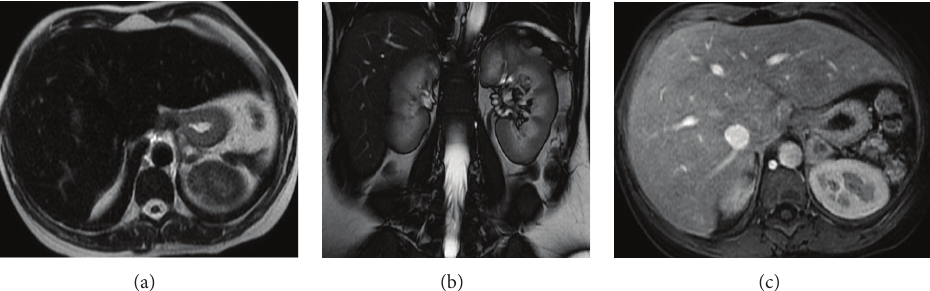
Figure 22: Autosplenectomy is found in a patient with homozygous sickle cell disease. Axial T2wi SSFSE (a), coronal SSFP (b), and postcontrast axial 3D-GRE T1wi with fat suppression at the arterial phase (c). Note the small remnant of spleen and the diffuse diminished signal intensity of the hepatic parenchyma on both T1wi and T2wi as a result of iron